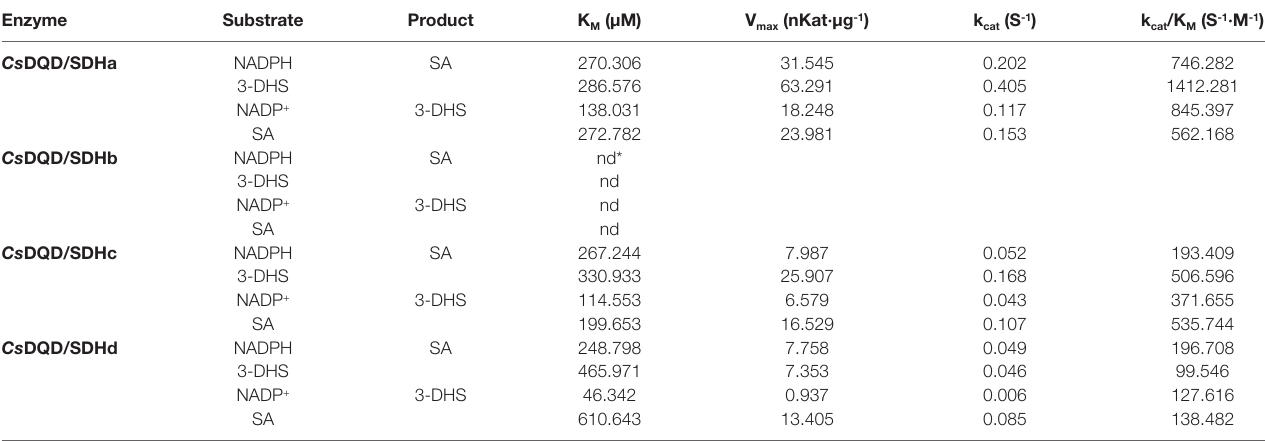
TABLE 1 | Michaelis–Menten kinetic parameters of recombinant Cs DQD/SDHs for each substrate. Enzyme